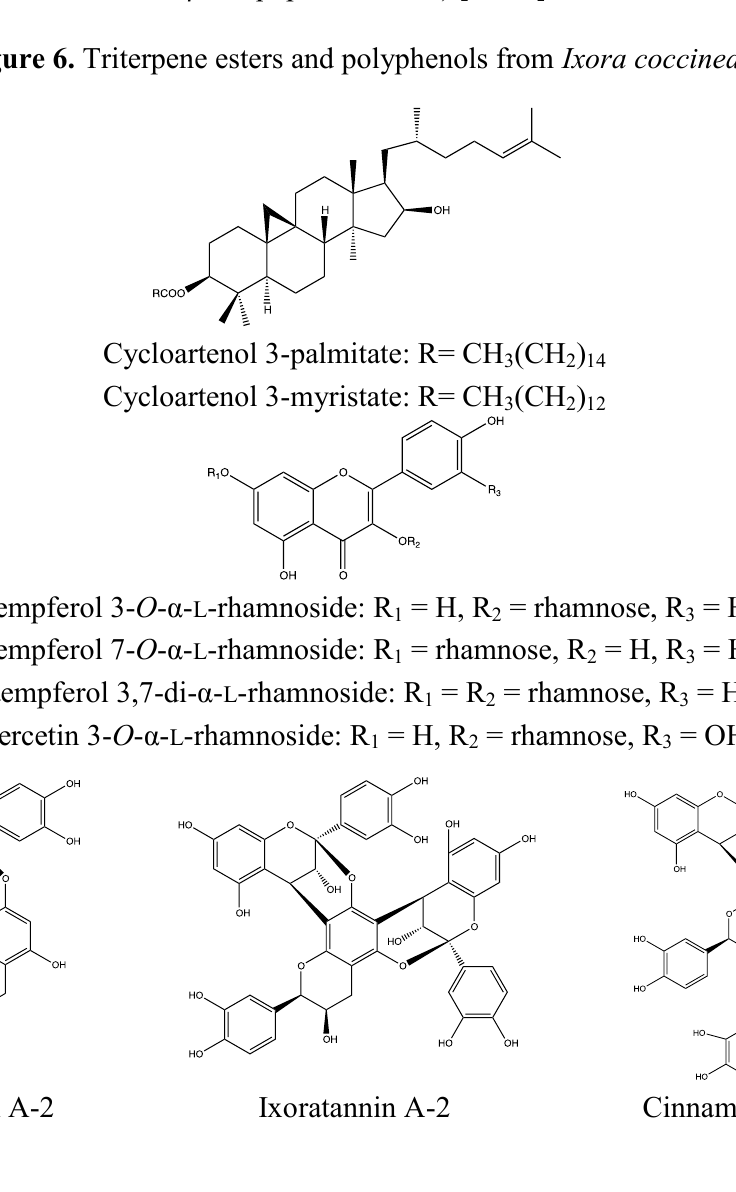
Figure 6. Triterpene esters and polyphenols from Ixora coccinea .